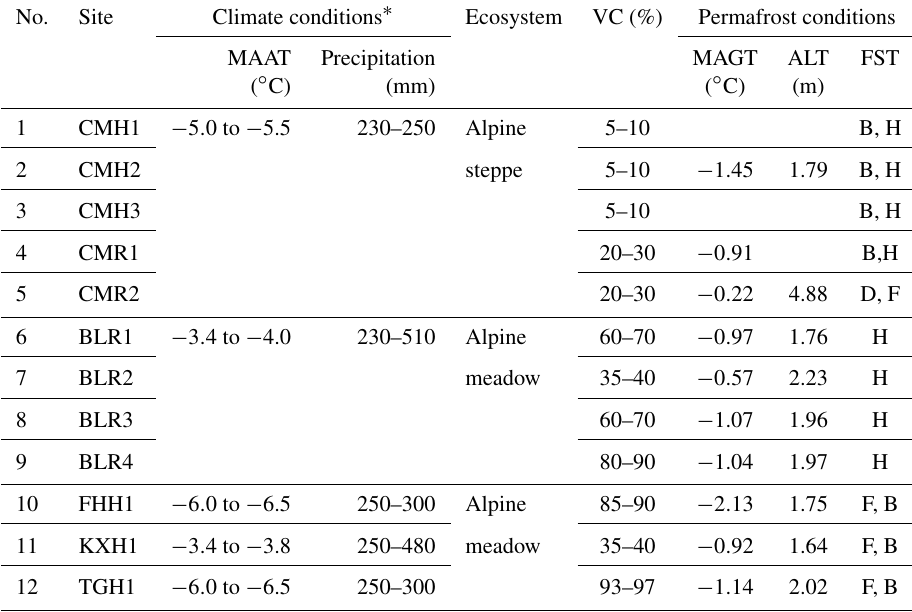
Table 2. Climate and environmental parameters at 12 monitoring sites along QTH and QTR. No. Site Climate conditions ∗ Ecosystem VC (%) Permafrost conditions MAAT Precipitation MAGT ALT FST ( ◦ C) (mm) ( ◦ C) (m) 1 CMH1 − 5 . 0 to − 5.5 230–250 Alpine 5–10 B, H CMH2 steppe